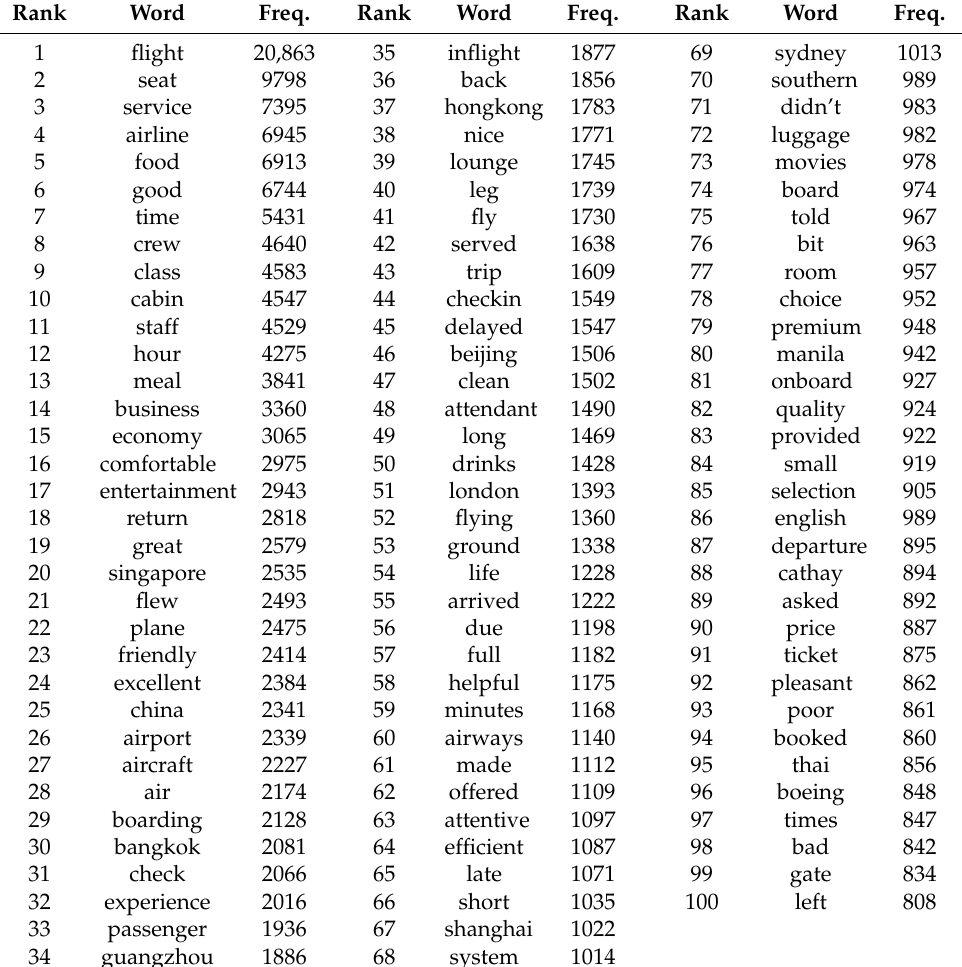
Table 2. The result of frequency